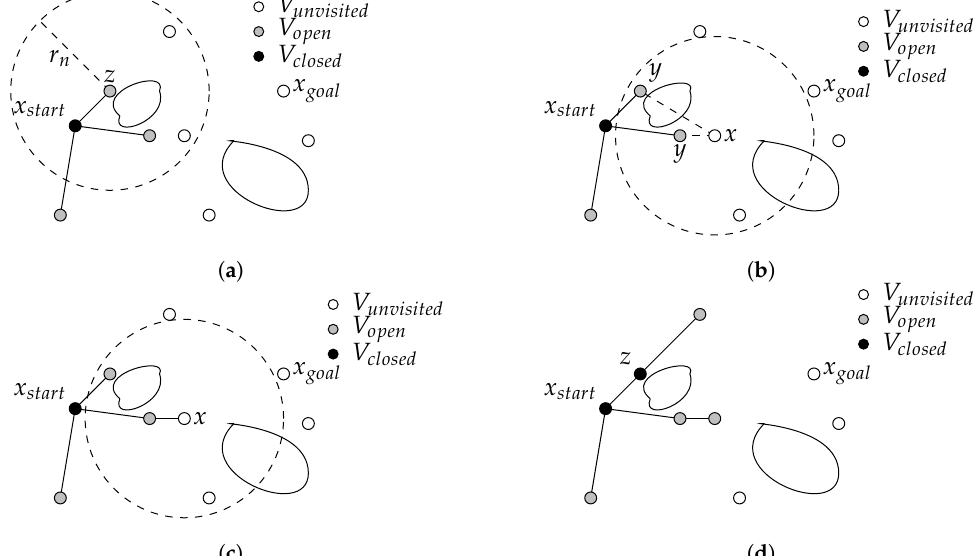
Figure 2. Local optimization phase [29]. ( a ) Lines 3–9. In this first step, the lowest-cost node z from set V open is selected and the nodes within V unvisited which are near to z are found. ( b ) Lines 10–13. For each unvisited node x near to z , its neighbors within V open are found, and x is connected to have an optimal cost without going through an obstacle. ( c ) Lines 14–18. A connection is created between x and the neighbor of the locally-optimal step connection. ( d ) Lines 20–25. All neighbors of z are visited and are added to V open . z is added to V closed . FMT* moves to the next iteration with the node which has the lowest cost. Table 1. Algorithm complexity depending on the number of samples n